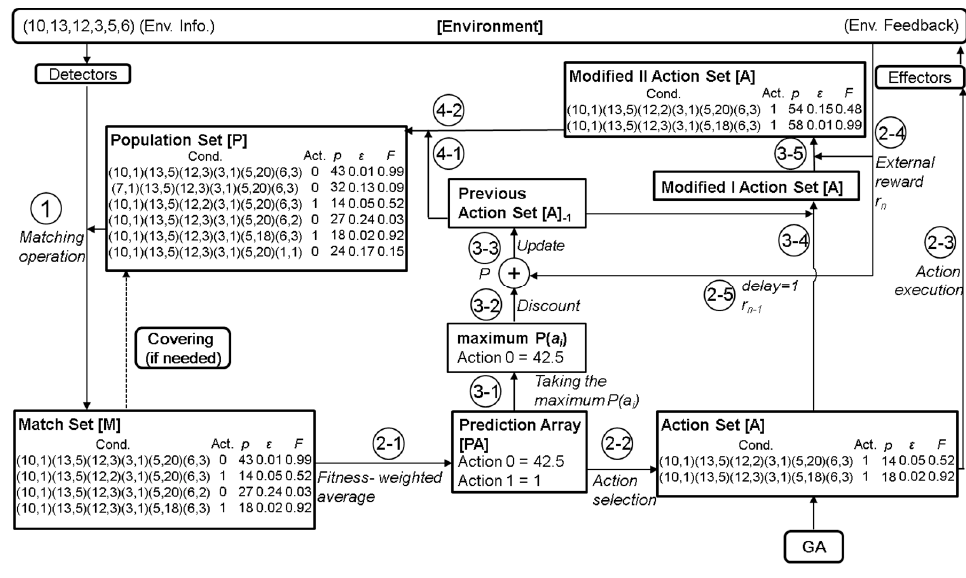
Figure 2. Schematic of the XCSR.